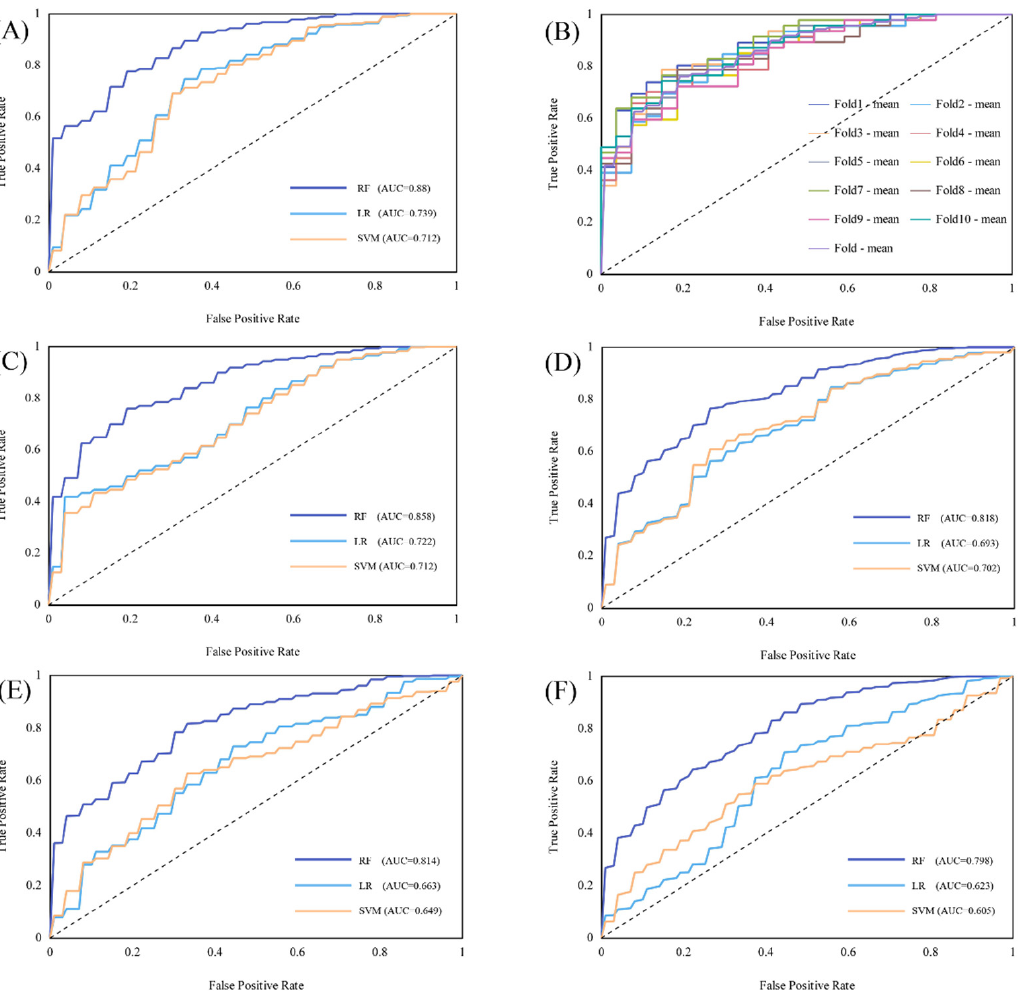
Figure 6. Receiver operating characteristic (ROC) curve demonstrating the performance radiomics models constructed by different classifiers (RF, LR, and SVM) in predicting RANKL status in spinal GCTB based on multiregional VOIs. ( A ) Entire tumor VOI (mean of 10-fold cross-validation); ( B ) Entire tumor VOI (each fold of 10-fold cross-validation); ( C ) Core area VOI (3 mm); ( D ) Edge zone VOI (3 mm); ( E ) Core area VOI (2 mm); ( F ) Edge zone VOI (2 mm). RF, random forests; LR, logistic regression; SVM, support vector machines.